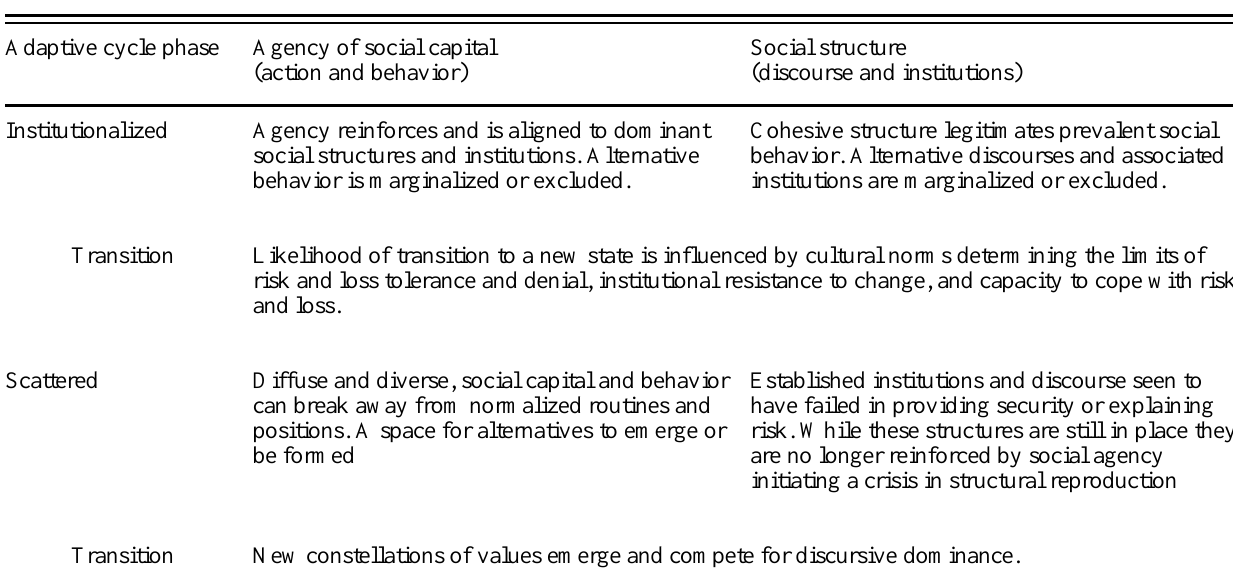
Table 1 . The adaptive cycle states and transition: social agency and structural qualities